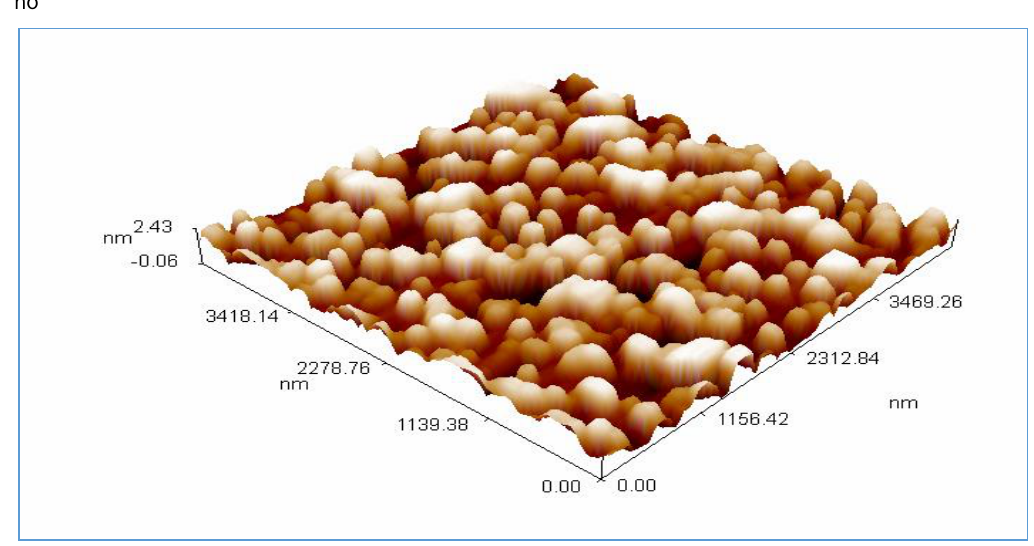
Figure 13. Three –dimensional morphology of darifenacin hydrobromide loaded NLCs ( F16)